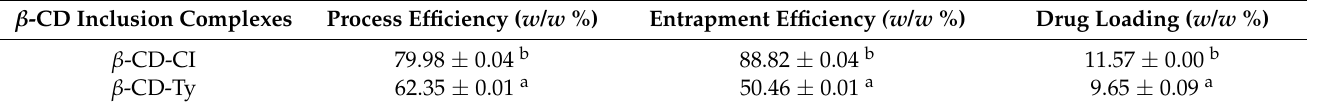
Table 1. Process efficiency, entrapment efficiency, and drug loading of active β -CD inclusion complexes.